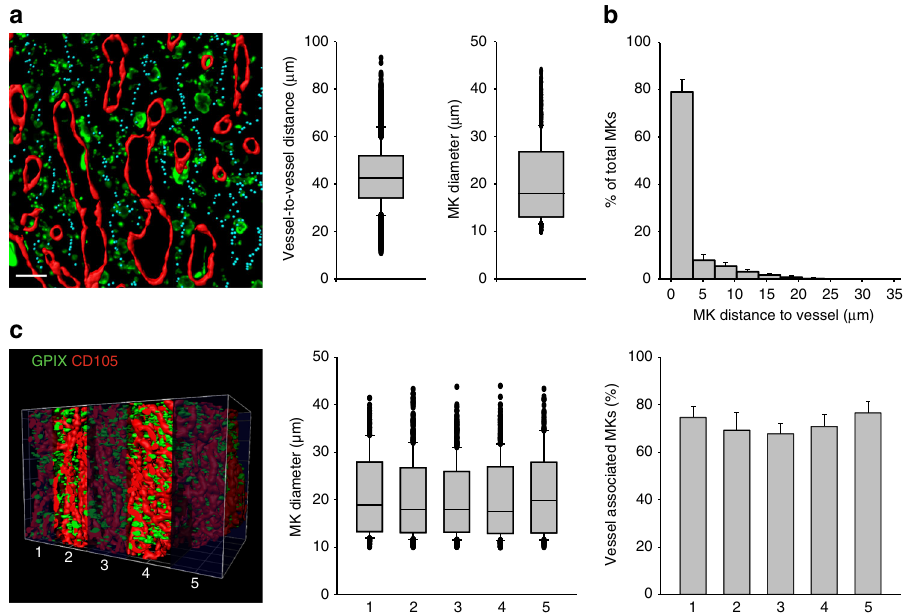
Fig. 3 The intervascular space limits MK distribution within the BM. a Reconstruction of sternal BM revealed a dense blood vessel network ( red , CD105) with limited space for MKs ( green , GPIX) shown by vessel-to-vessel distances and average MK diameter ( n = 5 mice). Cyan dots represent the center (maximal distance) between two adjacent vessels. Scale bar 50 µ m. b Most MKs are localized adjacent to sternal sinusoids and c MK diameters and MK distribution, shown by the percentage of vessel associated MKs, were comparable throughout the whole sternum in fi ve different sections of the reconstructed BM. Bar graphs represent mean ± SD; n = 5; grid square = 100 µ m. There are no signi fi cant differences in c ( p > 0.05; Mann – Whitney U